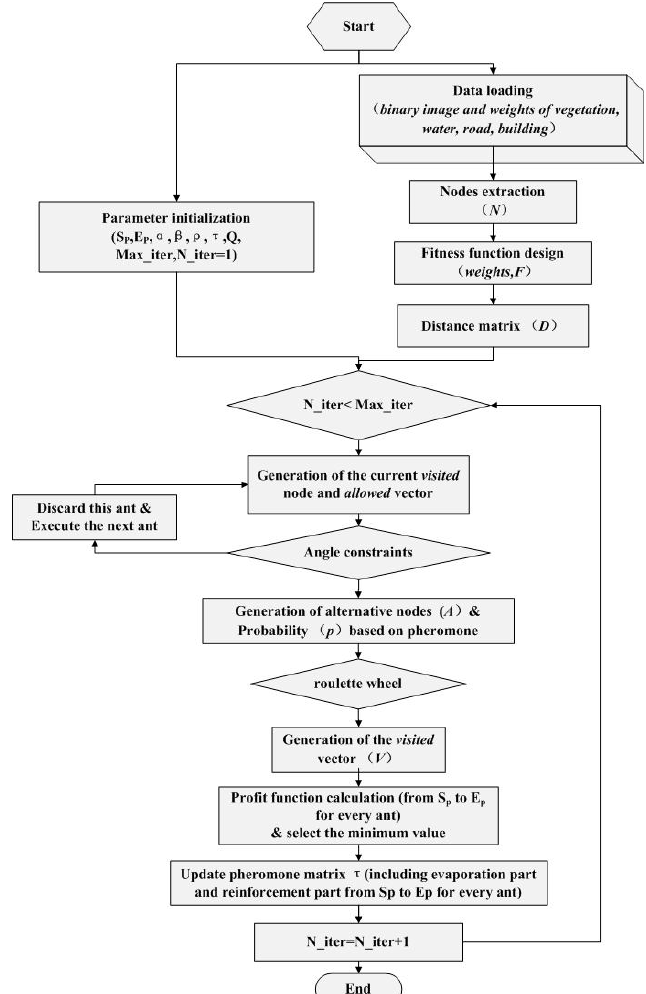
Figure 7. Flowchart of the modified ACO.